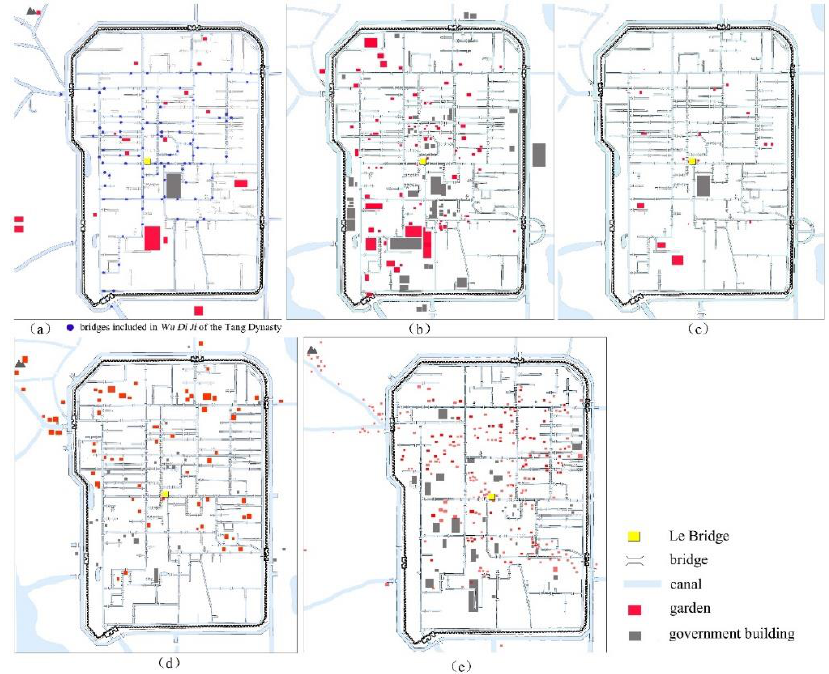
Figure 3. The distribution of government buildings and private gardens from the Tang to Qing Dynasty. ( a ) Tang Dynasty and the period of Ng- Yuih Kingdom. ( b ) Song Dynasty. ( c ) Yuan Dynasty. ( d ) Ming Dynasty. ( e ) Qing Dynasty.